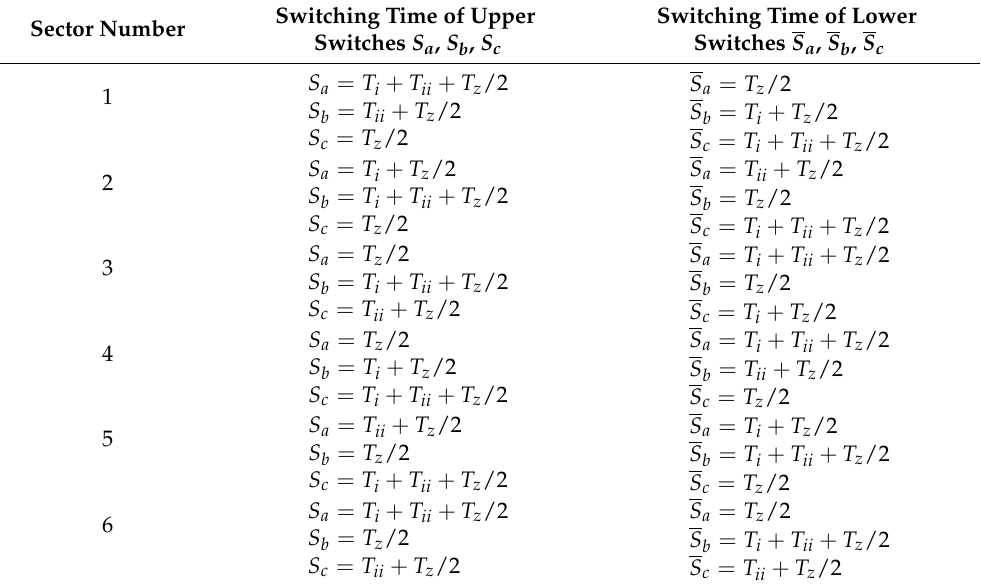
Table 1. Switching time at each